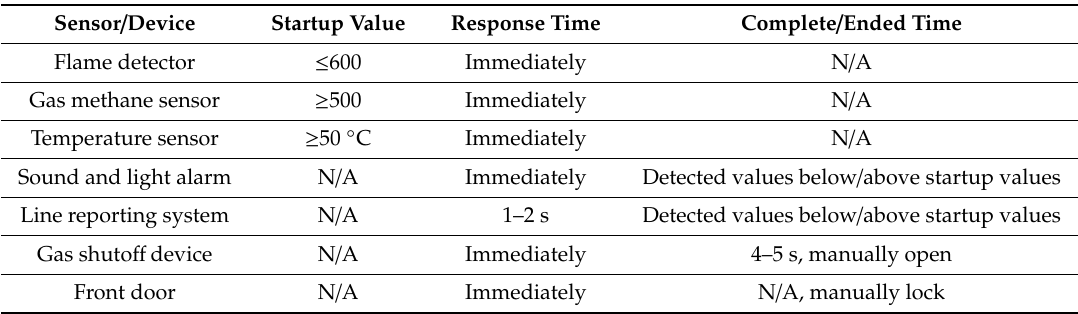
Table 3. The startup value, response time and complete time of sensors / devices used in this study.